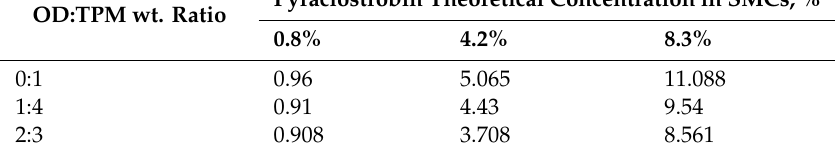
Table 3. The loading content of pyraclostrobin in SMCs depending on pyraclostrobin concentration and OD:TPM wt. ratio.